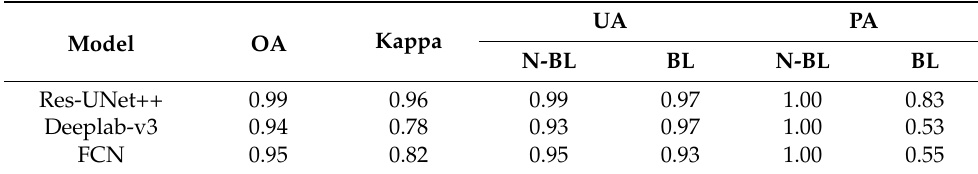
Table 2. Accuracy assessment of built-up land maps based on Res-UNet++, Deeplab-v3 and FCN model in 2020 (BL-Built-up land, N-BL-Non-Built-up land). Model OA Kappa